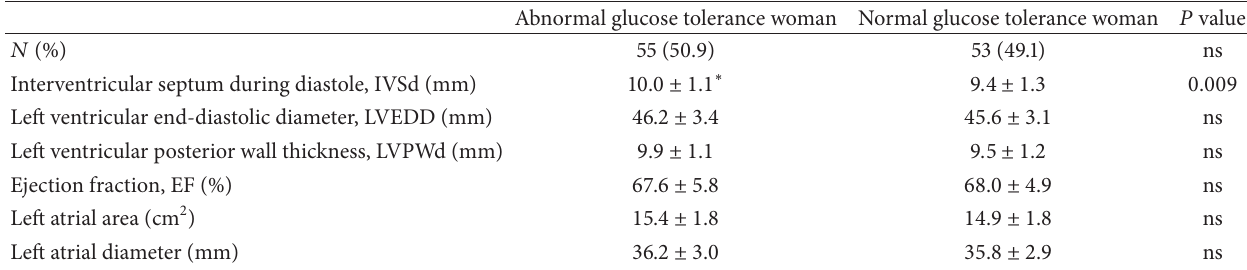
Table 2: Echocardiographic M-mode and 2-dimensional mode